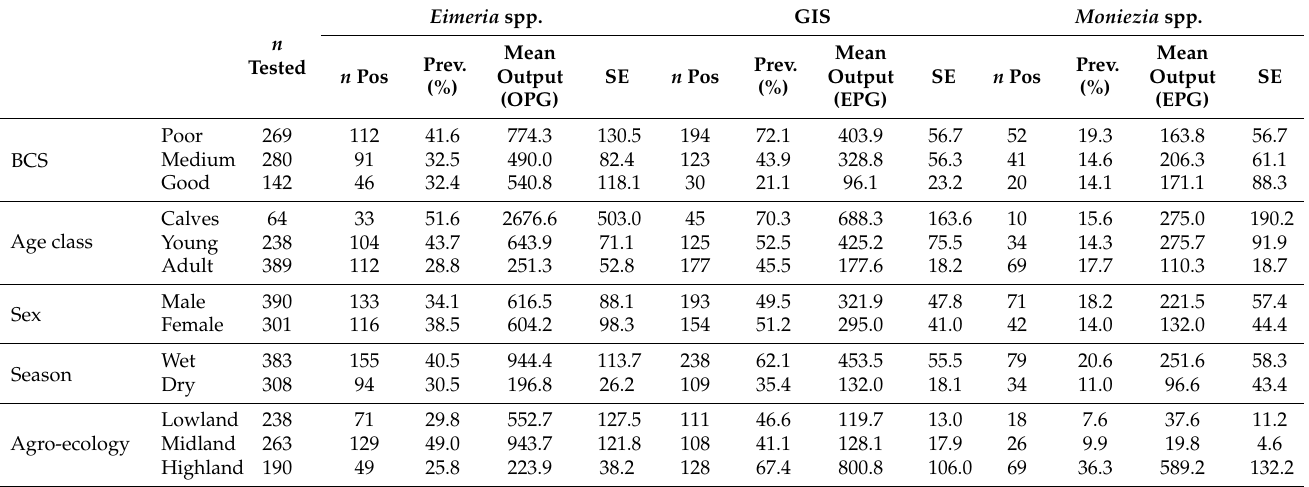
Table 3. Prevalence and abundance (mean output) of selected parasitic taxa in the subgroups identified by the individual (BCS, age and sex) and environmental (season and agroecology) factors. Eimeria spp. n Tested